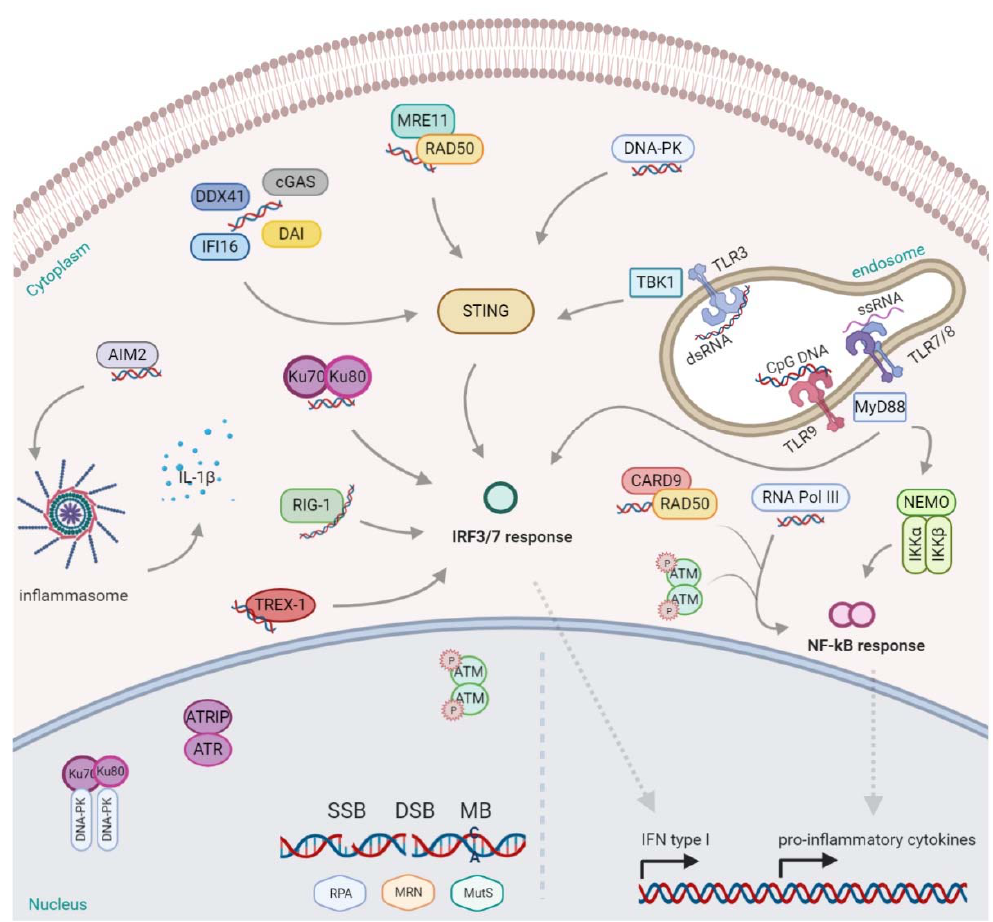
Figure 1. DNA sensing and activation of immune signaling.